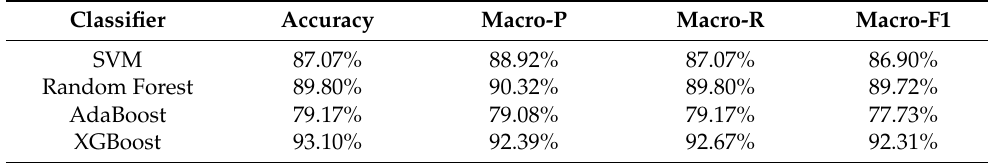
Table 3. Comparison of Classification Performance of Different Classifiers.